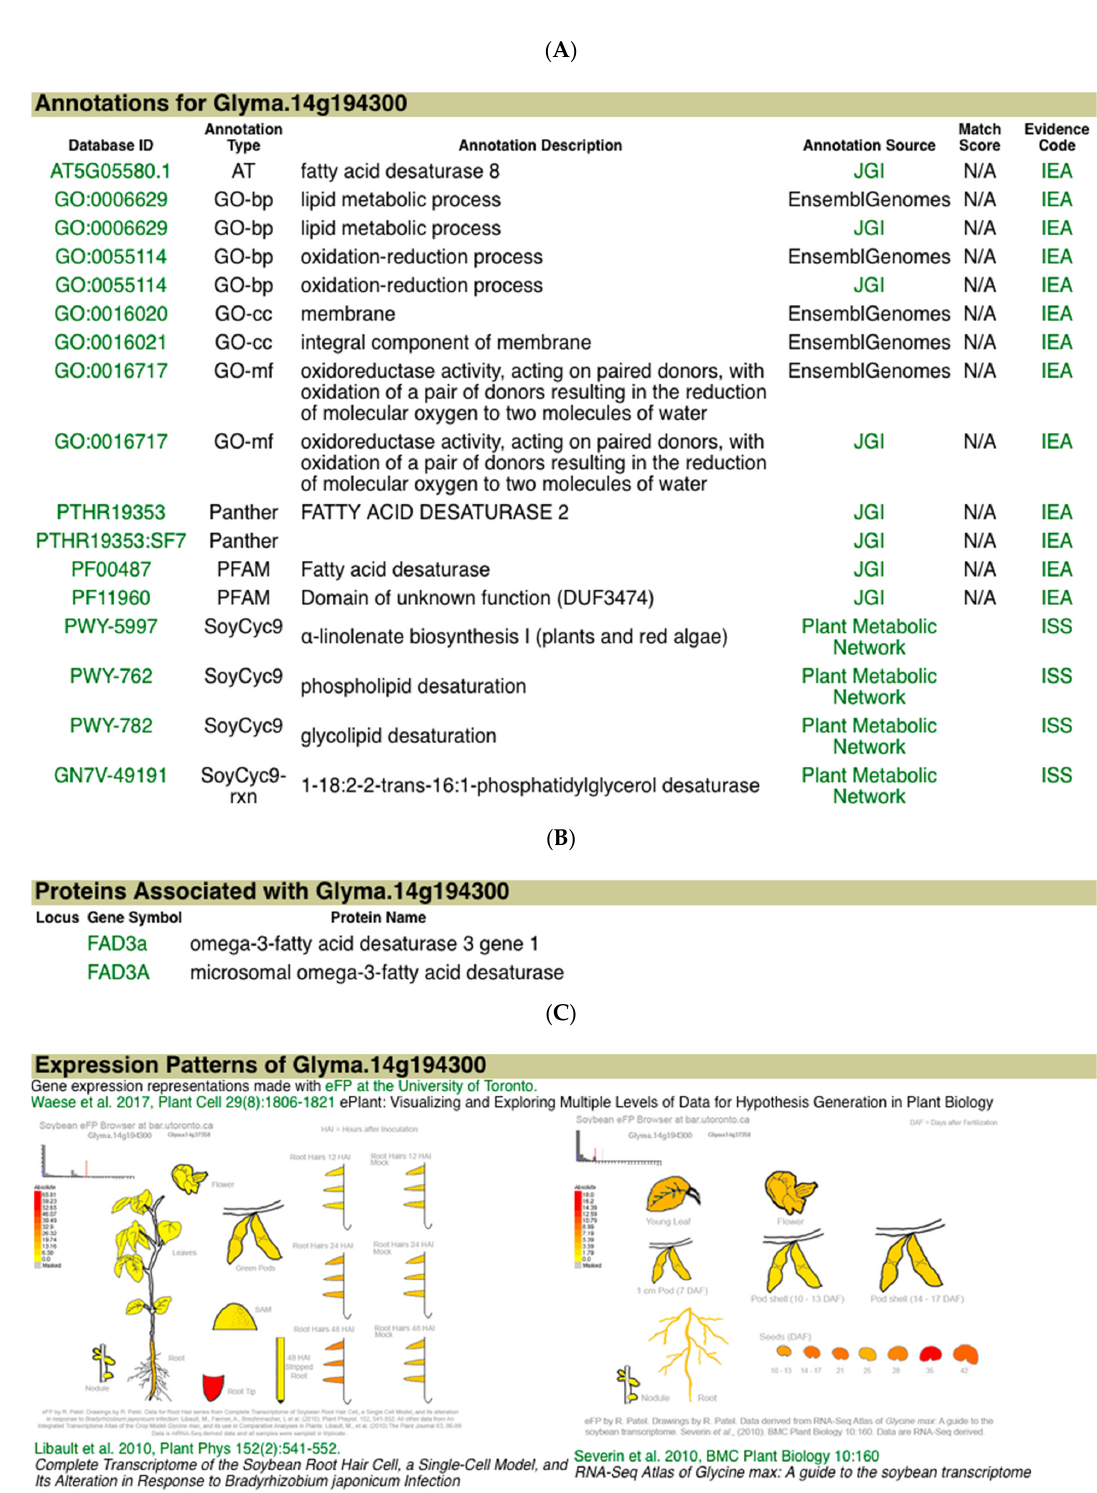
Figure 5. Detailed gene report for Glyma.14g194300. Details of the SoyBase gene report for the candidate gene Glyma.14g194300. ( A ) Functional and biochemical pathway annotation of the candidate indicates that it is a fatty acid desaturase and functions in the α -linolenate biosynthesis I pathway of plants and algae. Evidence codes are described at the GO evidence code page. ( B ) The protein product of this gene has been identified as FAD3A, a microsomal ω -3-fatty acid desaturase gene known to be involved in seed linolenic acid biosynthesis in soybean. ( C ) Expression of this gene measured by RNAseq is elevated in seed and shoot apical meristem